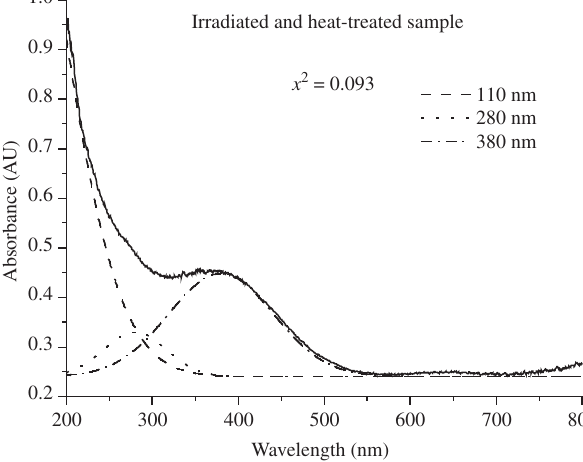
Figure 4. Curve fittings for UV-VIS spectrum from irradiated (80 kGy) and heat-treated